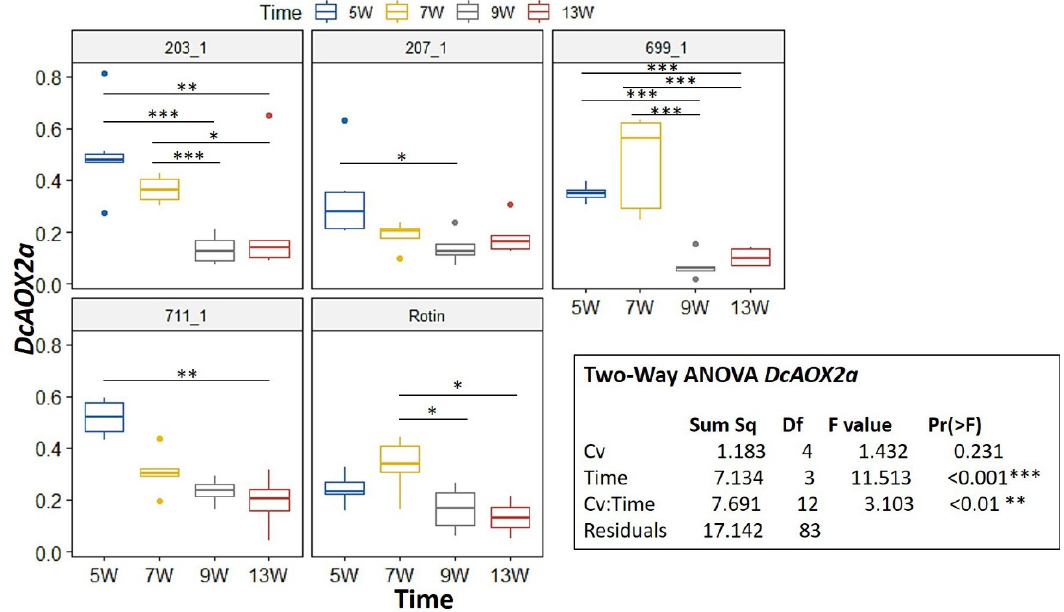
Figure 4. Expression box-plot and two-way ANOVA analysis for DcAOX2a during carrot root secondary growth in the cultivars (Cv) 203-1, 207-1, 699-1, 711-1, and ‘Rotin’. Transcript levels were determined by RT-qPCR. For each time point, four to six biological replicates were considered per cultivar. Significant differences in gene expression between time points are indicated by * ( p < 0.05), ** ( p < 0.01), or *** ( p < 0.001). Boxplots show the distributions (median, spread and outliers) of the gene expression values.